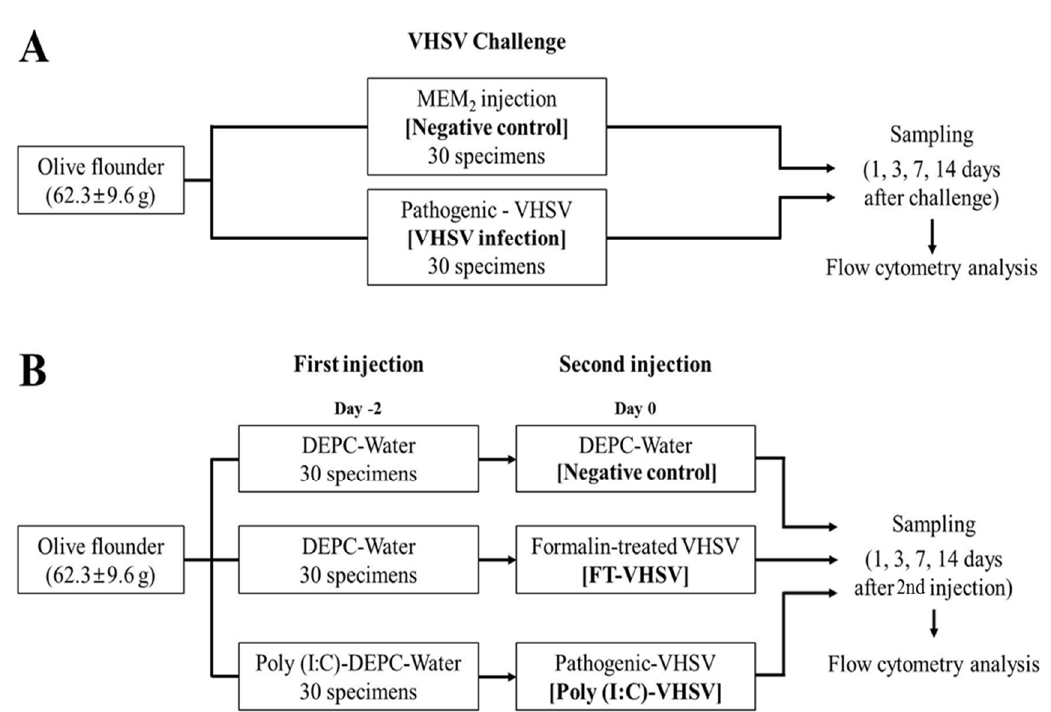
Figure 1. The experimental design of VHSV challenge and vaccination trials. ( A ) Set-up of VHSV infection, VHSV was injected into fish in the VHSV infection group ( n = 30), while MEM 2 was injected into fish in the negative control group ( n = 30). ( B ) In the vaccination experiment, fish in the (Poly (I:C)-VHSV) group were injected with Poly (I:C) two days before they were inoculated intraperitoneally with live VHSV at 0 dpv ( n = 30). Fish in the FT-VHSV group were injected with DEPC-treated water two days before inoculation intraperitoneally of formalin-treated VHSV ( n = 30). The negative control group was injected with DEPC-treated water at both -2 dpv and 0 dpv ( n = 30).